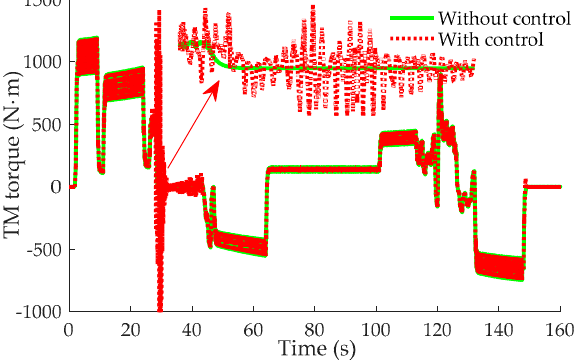
Figure 18. Traction motor (TM) motor output torque.